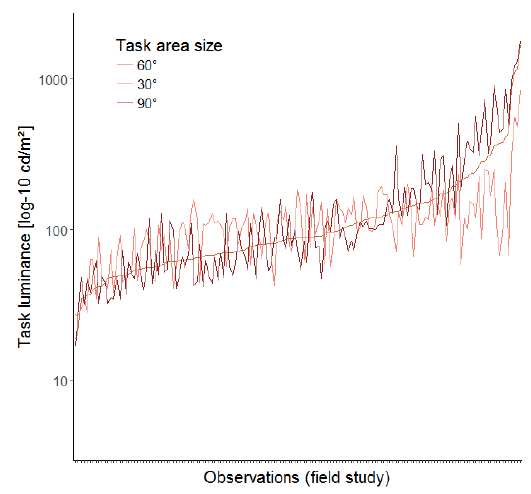
Figure 30. Comparison of the task area average luminance between the three different task area sizes for all glare evaluations of the field study. Buildings 2018 , 8 , x FOR PEER REVIEW